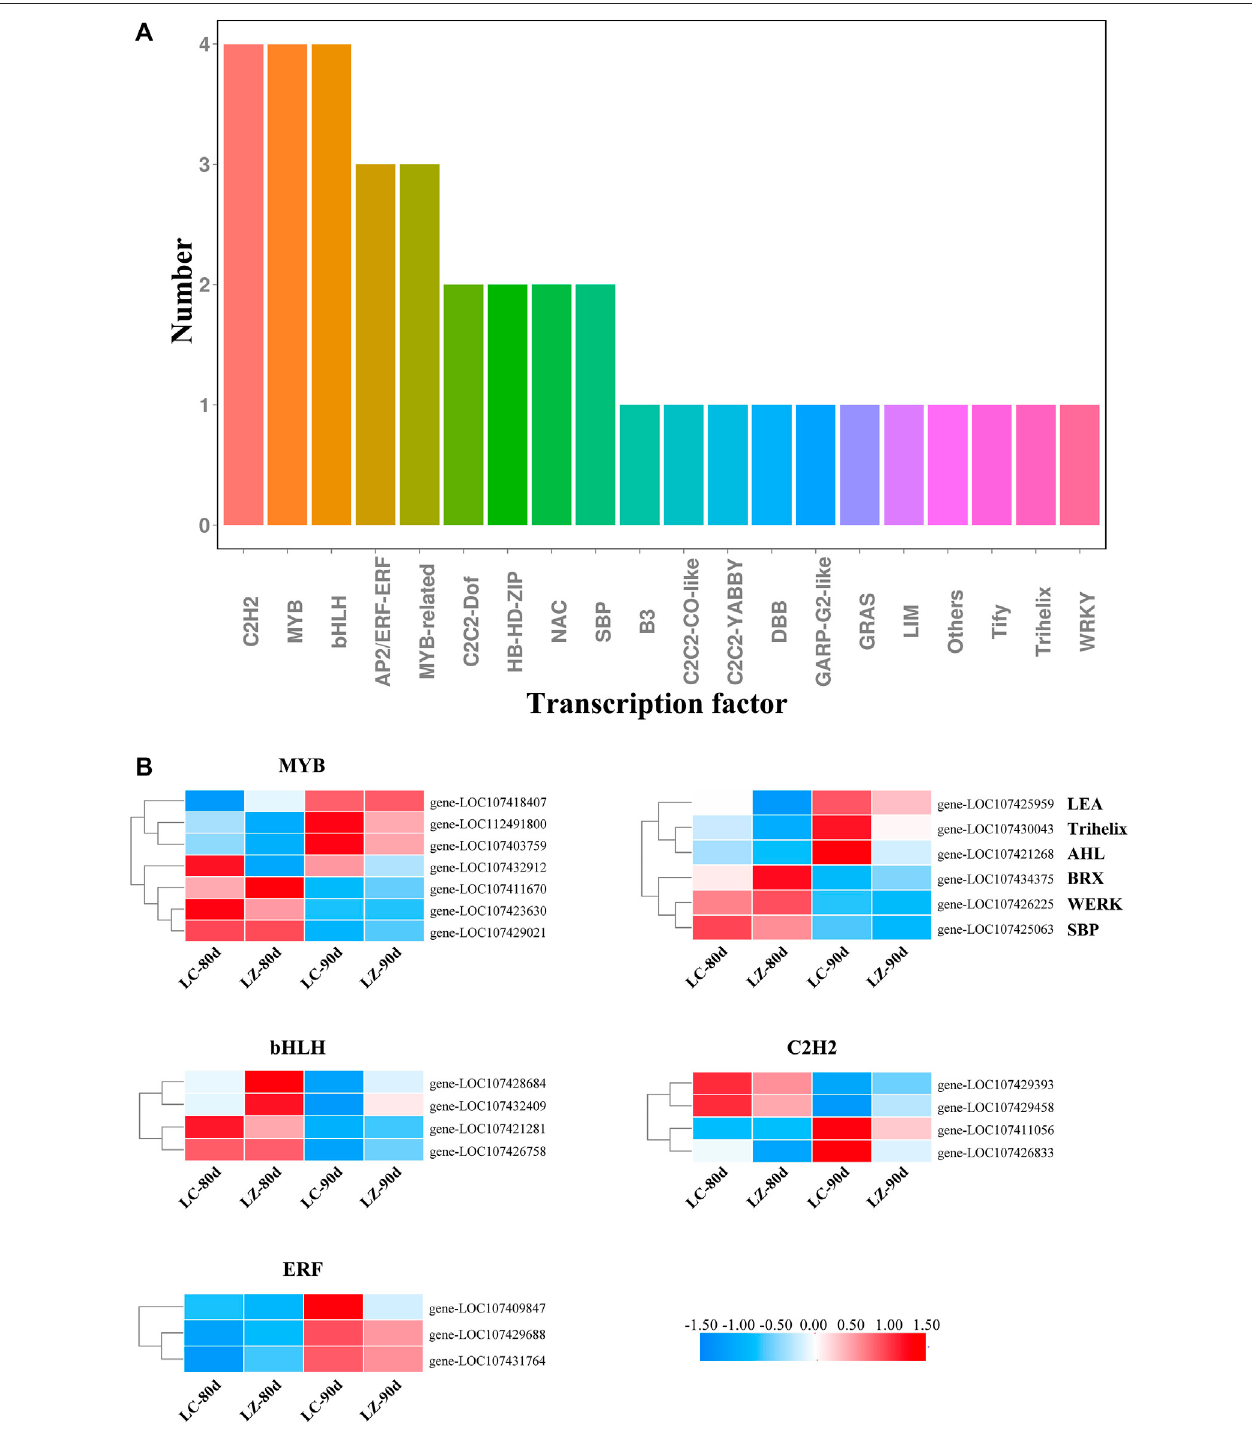
FIGURE 5 | The classi fi cation of transcription factor family members and their differential expressions during the late fruit-ripening stage. (A) Classi fi cation of transcription factor family. (B) Differential expressions of main transcription factor family members.